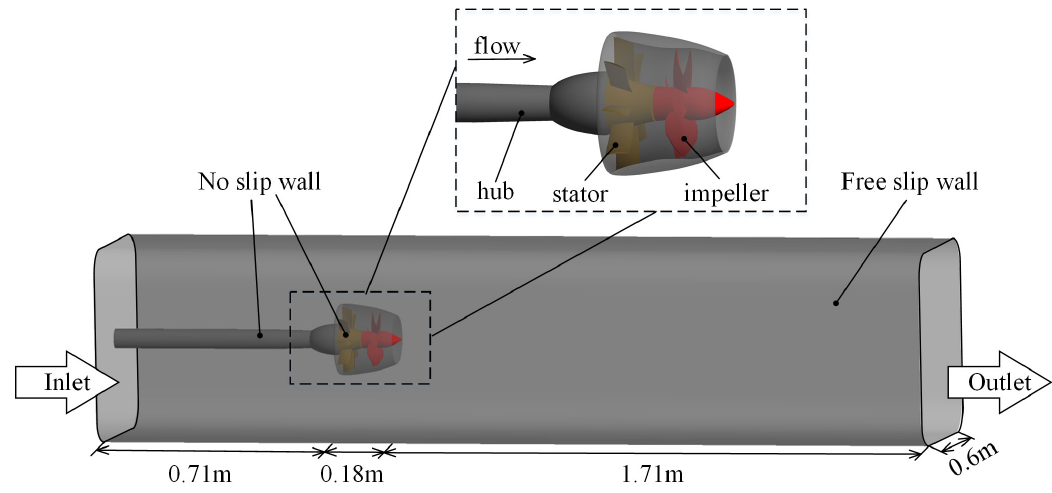
Figure 1. Computational zone and boundary condition.